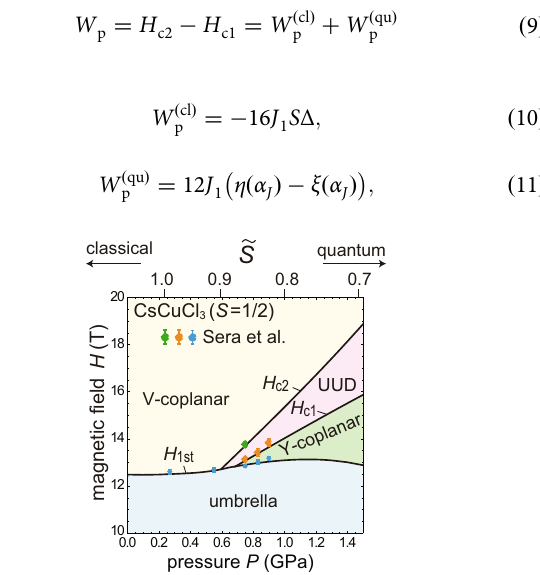
Fig. 6 H – P phase diagram. Theoretical ground-state phase diagram of the model for CsCuCl 3 in the plane of magnetic fi eld H and external pressure P . We mark the points at which the magnetization anomalies have been observed in the experiments of ref. 10 at temperature T = 1.5 K by the fi lled circles with error bars (blue: magnetization jump; orange: kink in between the jump and plateau; green: end point of the plateau). The corresponding values of the effective spin ~ S in the squashed model are indicated on the upper